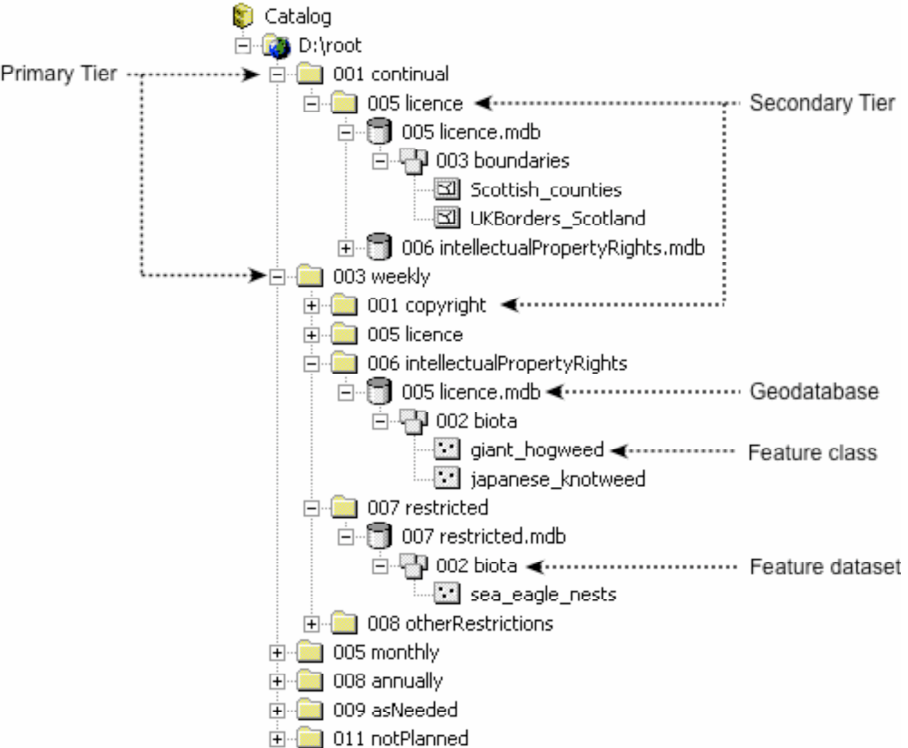
Figure 1. A prototype data container hierarchy, yielding five metadata elements (adapted from Batcheller [35]). Containers are instantiated on arrival of new datasets; an entire UK GEMINI-based hierarchy need not be